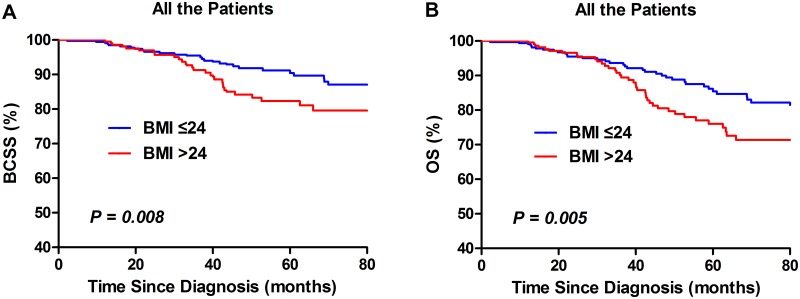
Kaplan–Meier curves of BCSS (A) and OS (B) by BMI groups in all TNBC patients.